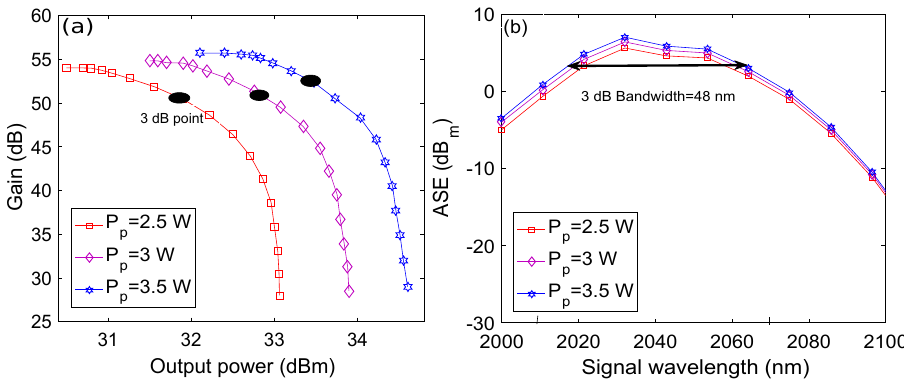
Figure 6. ( a ) Gain versus output power plots as a function of pump power ( b ) ASE versus signal wavelength plots as a function of pump power.